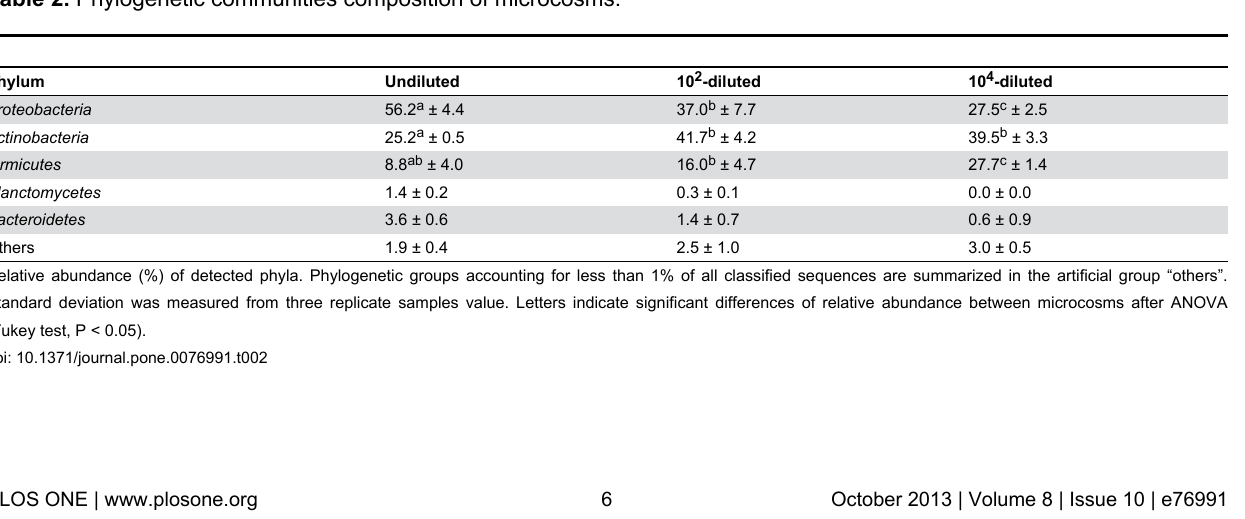
Table 2. Phylogenetic communities composition of